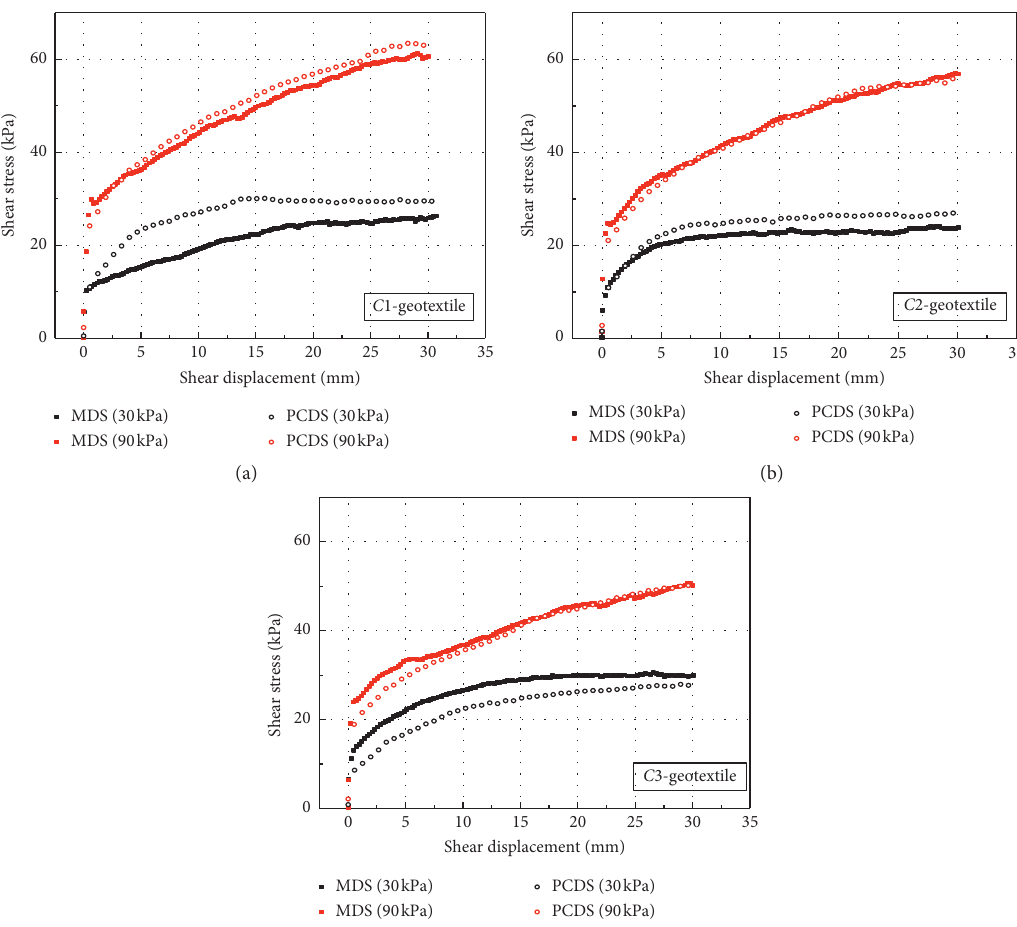
Figure 8: Comparison of the shear stress-shear displacement curves for the MDS and PCDS